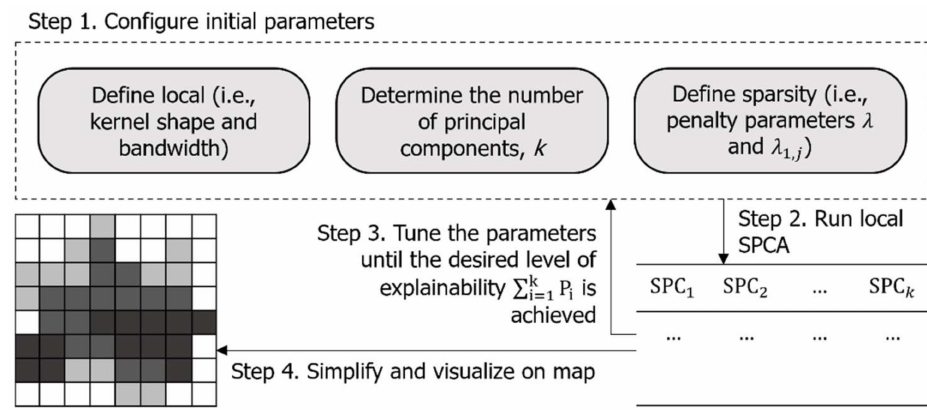
Figure 3. Calculation process of the proposed